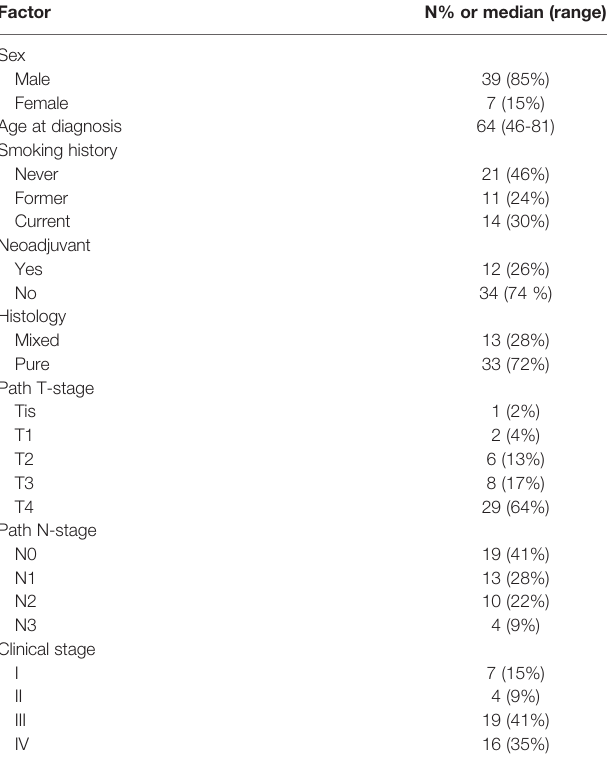
TABLE 1 | Patients ’ Clinicopathological